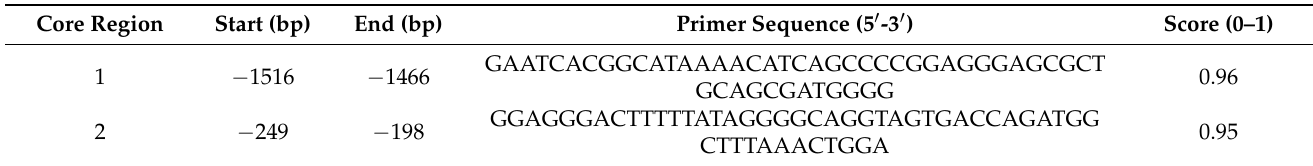
Table 4. Prediction of the core region of ZP2 gene promoter in Jinghai Yellow Chicken.